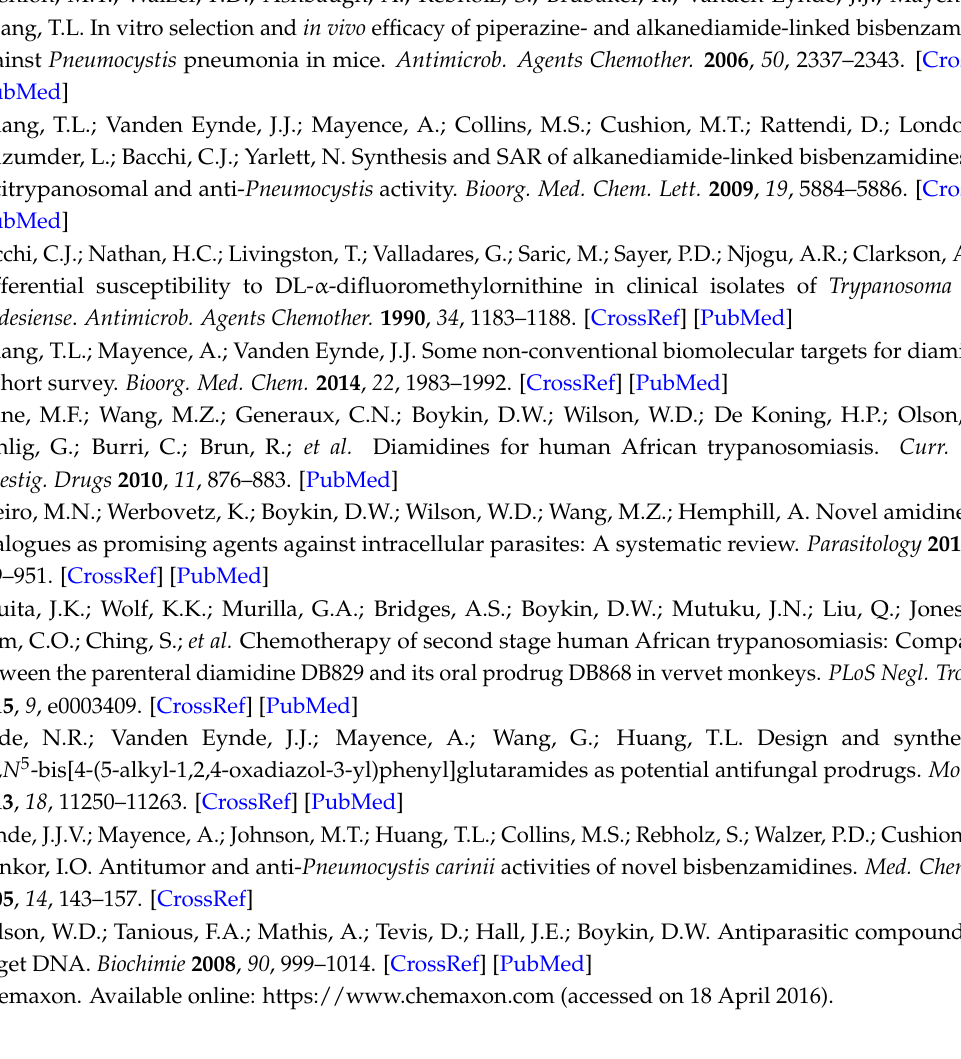
Figure S1: Correlation between the experimental pIC 50 in different cell lines and the ∆ T m with poly(dA-dT), Figure S2: Detailed views from the minor groove of the hydrogen bond interactions between compounds 11 and 15 and the central –AAAGTTT- sites of 5’-d(CCAAAGTTTGC)-3’ duplex, Table S1: Docking of alkanediamide-linked bisbenzamidines and analogs to various DNA duplexes with specific central sequences, in vitro antiparasitic properties (pIC 50 ) and thermal melting data ( ∆ T m ) of tested analogs with poly(dA-dT) and CT-DNA, Table S2: Pearson’s correlation ( r ) between the experimental pIC 50 values of three cell lines or ∆ T m of poly(dA-dT) and the docking scores for different central minor groove of sequences. Details of molecular modeling studies. Acknowledgments: The work described in this manuscript has been funded in part by the (NIMHD-NIH) under grant number